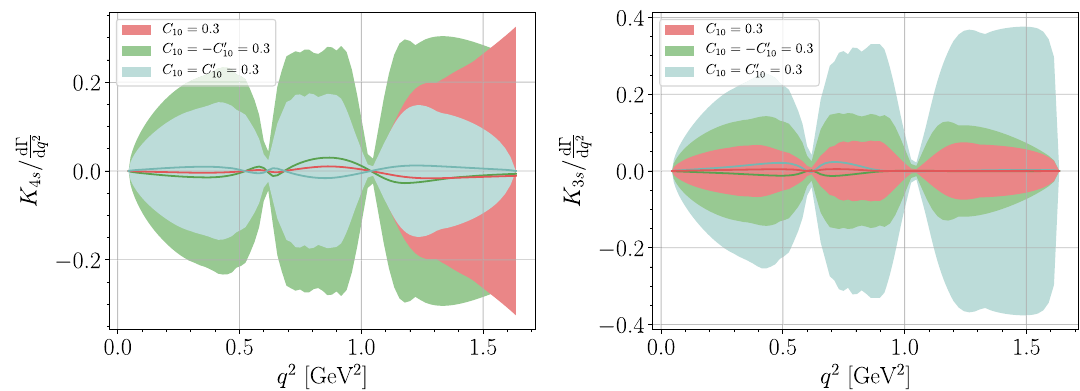
Fig. 3 The angular observables K 4 s (left) and K 3 s (right) normalized to the differential decay rate for (cid:2) + c → (cid:3) + ( → p π 0 )μ + μ − decays in different NP scenarios for C 10 and C (cid:3) . The width of the bands stem predominantly from unknown strong phases. Both observables are clean SM 10 null tests, see Eq.